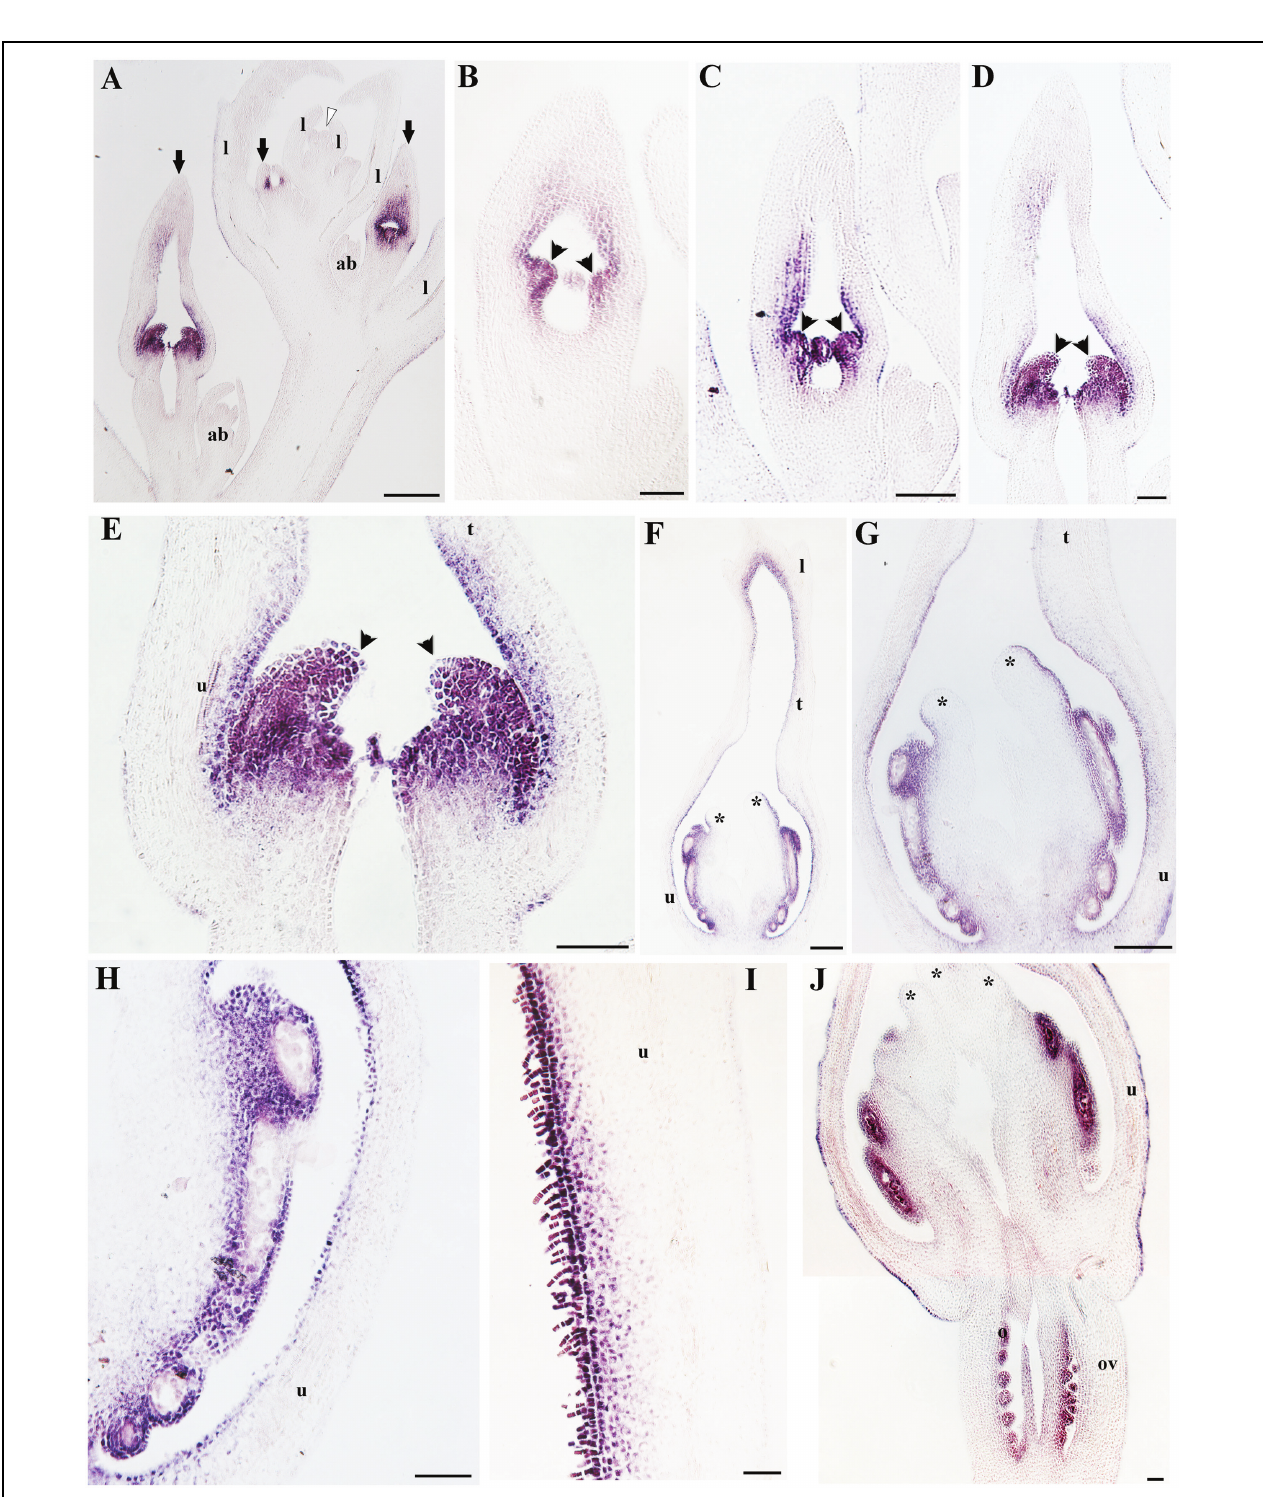
FIGURE 10 | In situ hybridization of AfimPI . (A) Flowering shoot apex in longitudinal section; note expression in stamens and surrounding perianth tissue. (B) Stamen initiation at S3. (C) Stamen growth at S4. (D,E) Utricle, tube and limb differentiation together with stigmatic tissue initiation at S5; note expression in the young gynostemium. (F–J) Longitudinal sections and details of a floral bud at the utricle/gynostemium level at S7 (H) and the distal-most adaxial portion of the utricle (I) ; note expression in the adaxial epidermis, trichomes and hypodermis. Black arrows indicate medial sepal; black arrowheads indicate anthers; white arrowhead indicates shoot apical meristem (SAM); asterisks indicate stigmas; ab, accessory bud; l, leaf; o, ovules; ov, ovary. Scale bars: (A–D,F,G) : 100 μ m; (E) : 150 μ m; (H,I,J) : 50 μ m.